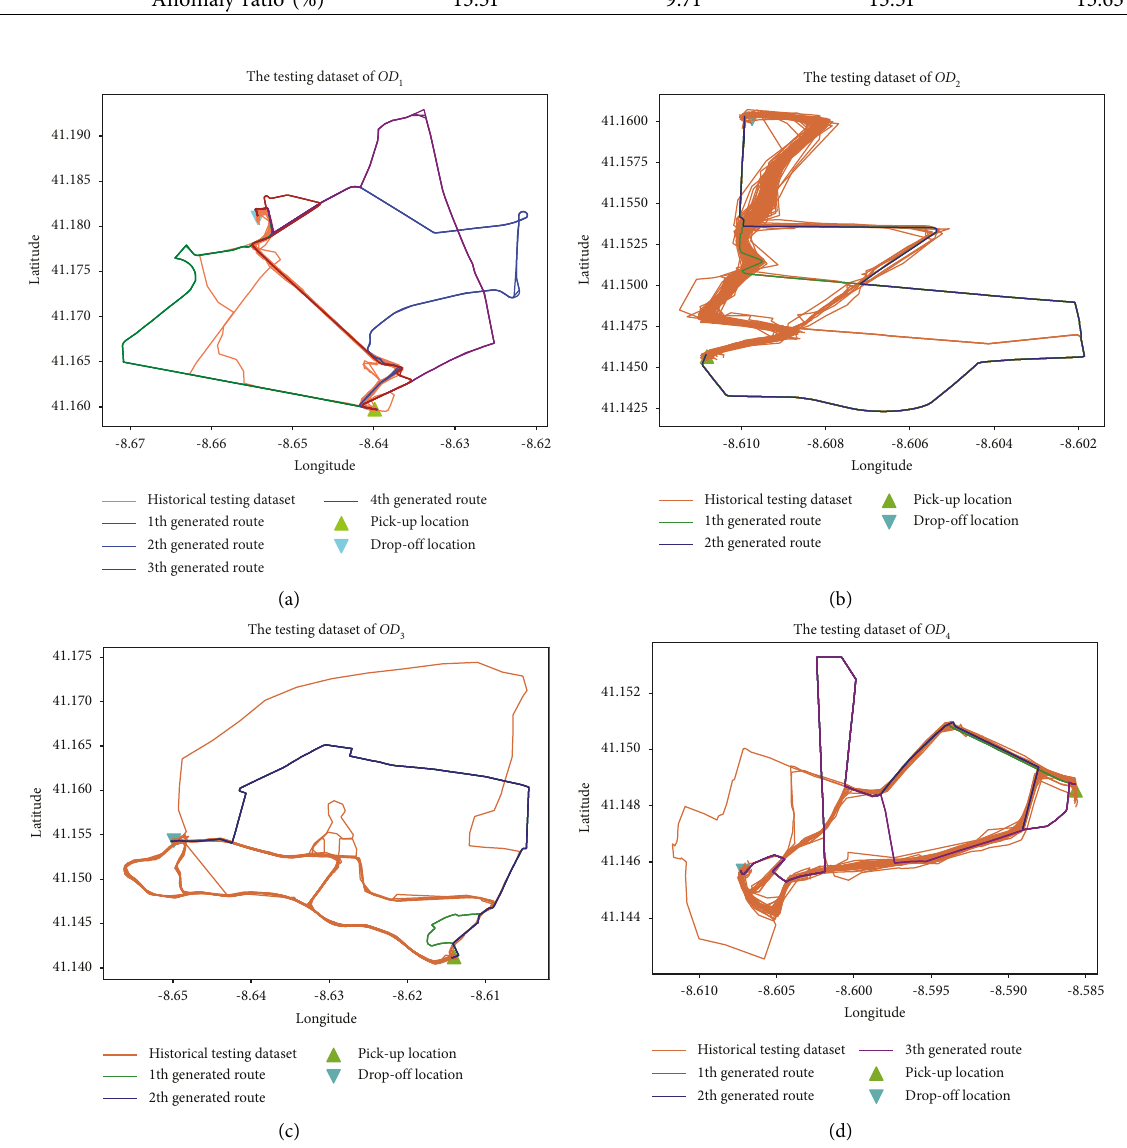
Figure 4: The testing dataset of each OD pair, where the lawn green color upper triangle represents the pick-up location and the cyan color lower triangle represents the drop-off location. (a) OD 1 , (b) OD 2 , (c) OD 3 , and (d) OD 4